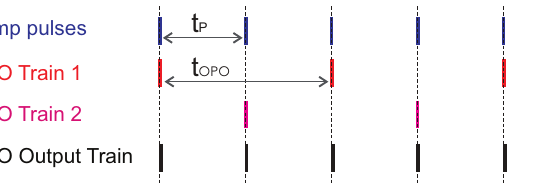
Figure 17. Scheme of subharmonic OPO generation, OPO cavity length is the double of the pump cavity length. t p is pump round-trip time, t OPO is OPO round-trip